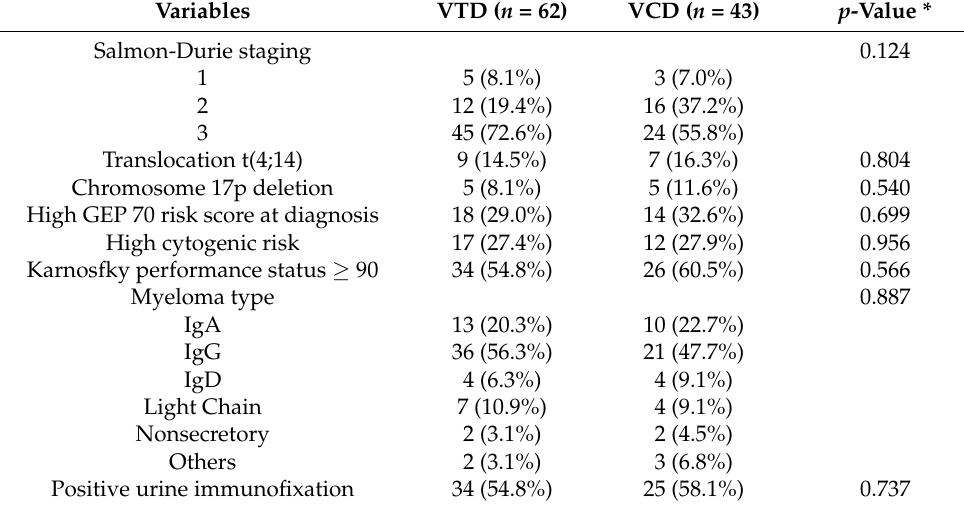
Table 2. Multiple myeloma characteristics in the two study groups before pretransplant therapy.